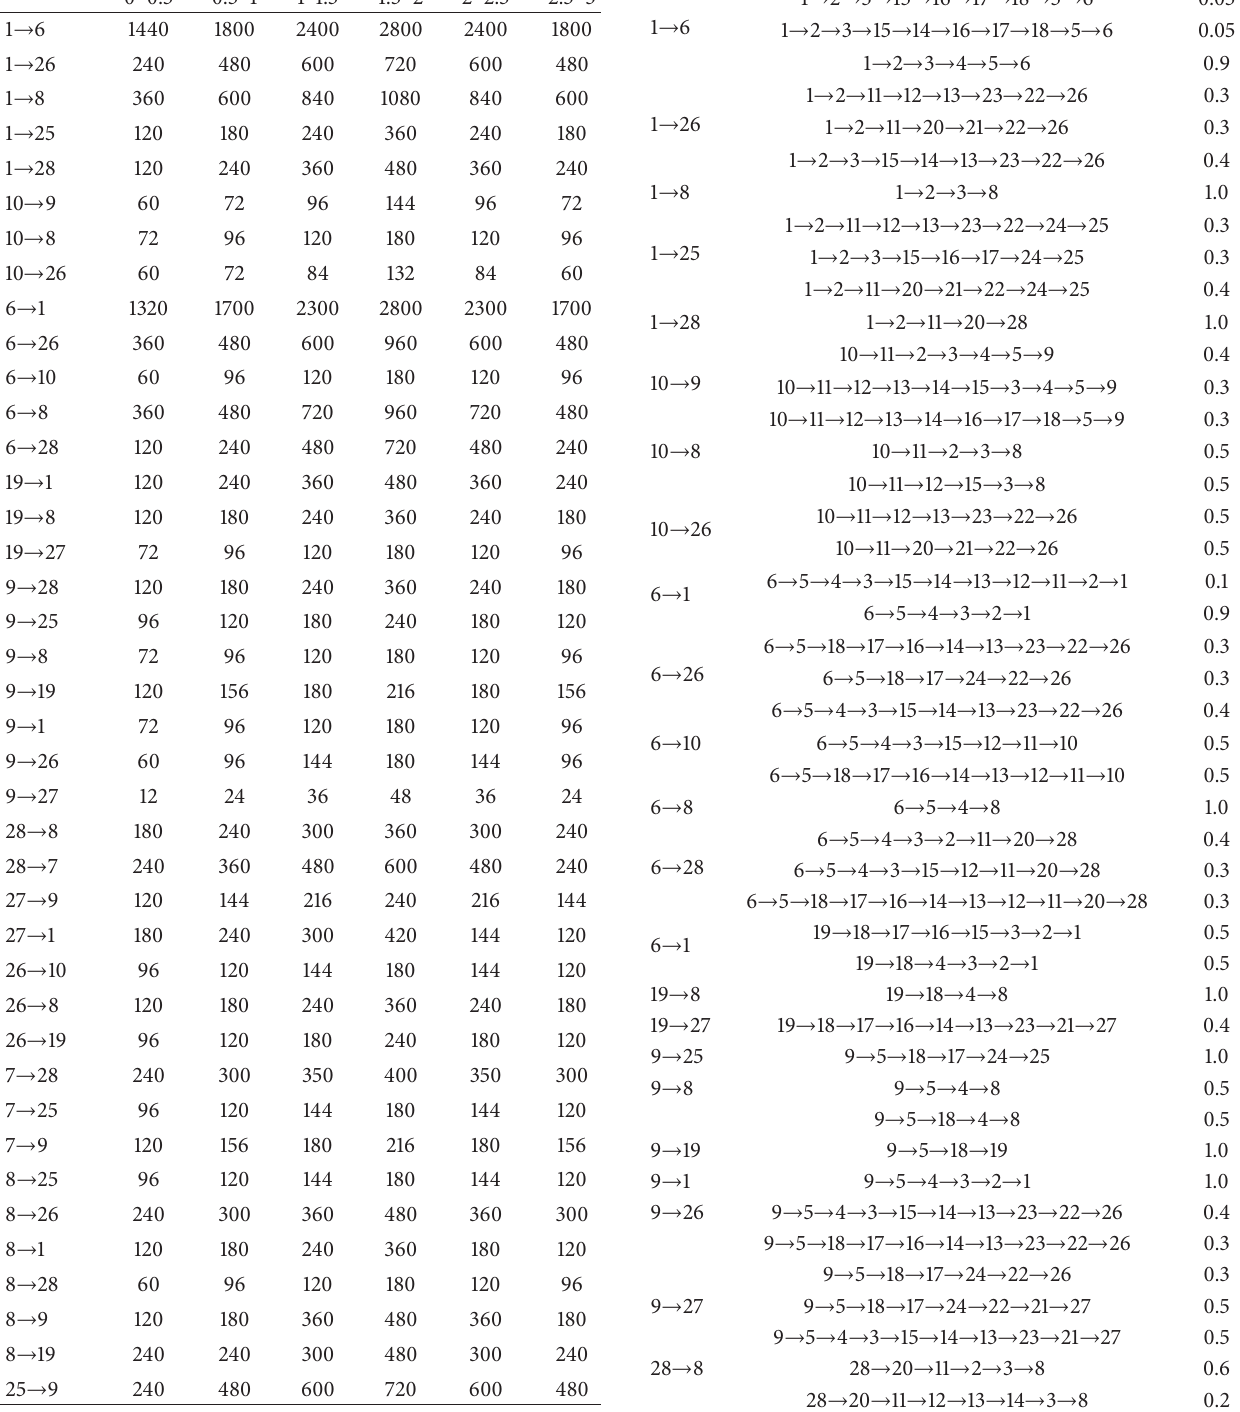
Table 10: Time-dependent OD flows (veh/hr). Node pair